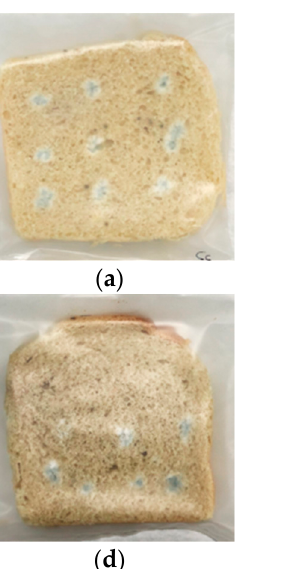
Figure 1. Bread slices contaminated with P. commune CECT 20767 after seven days of incubation at room temperature. Different treatments were carried out: ( a ) Control treatment; ( b ) 2.5 g/kg of white mustard bran (MB); ( c ) 5 g/kg of MB; ( d ) 7.5 g/kg of MB; ( e ) 10 g/kg of MB, and ( f ) Commercial treatment with sodium propionate (E-281).